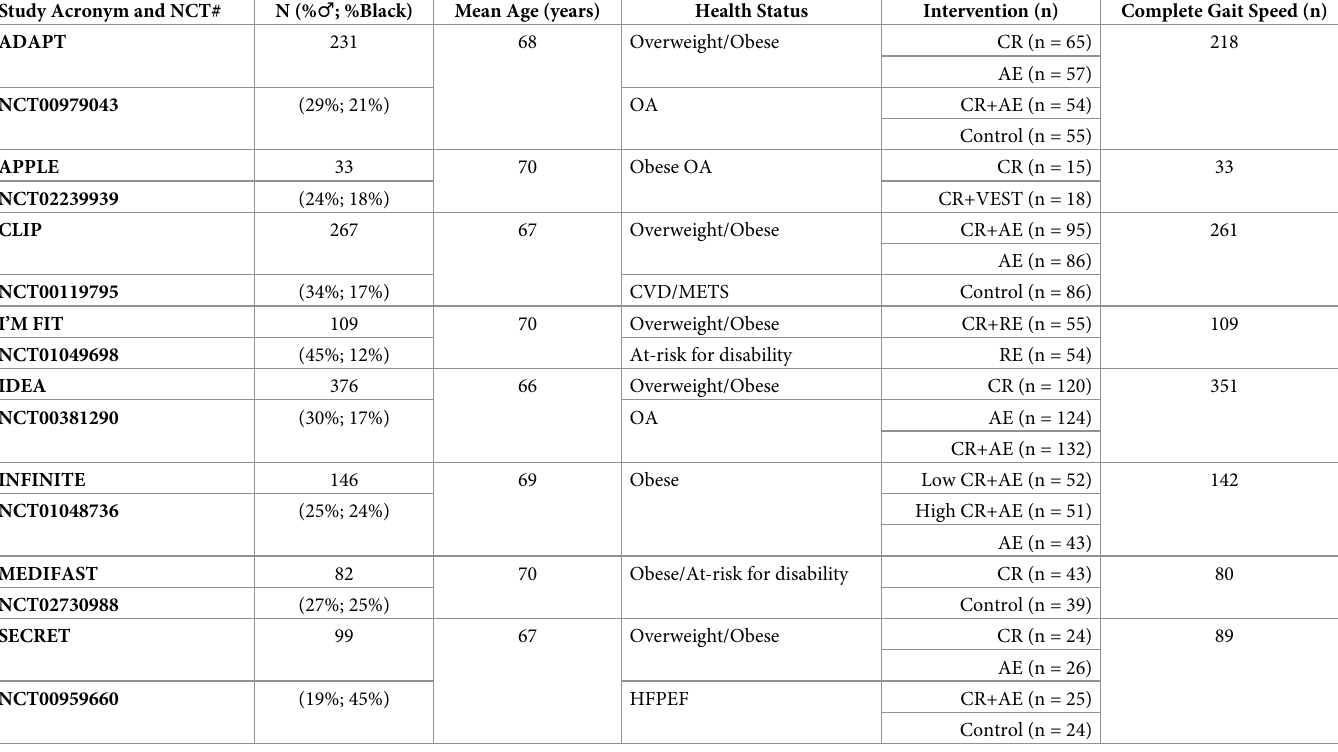
Table 1. Descriptive summary of randomized controlled trials included in the pooled